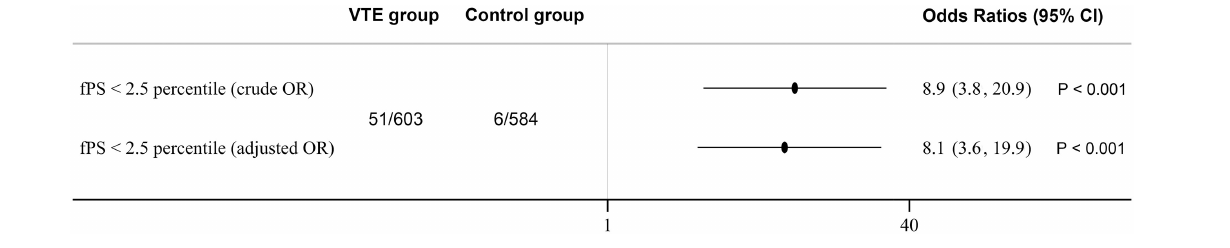
the plasma level of free protein S antigen or PROS1 mutations were calculate through the Chi-squared test. Multivariate logistic regression analysis was performed to adjust the odds ratios (OR) for selected confounders (age and gender). Statistical significance was accepted at P < 0.05. The statistical analyses were carried out using SPSS 19.0 (SPSS Inc., Chicago, IL,